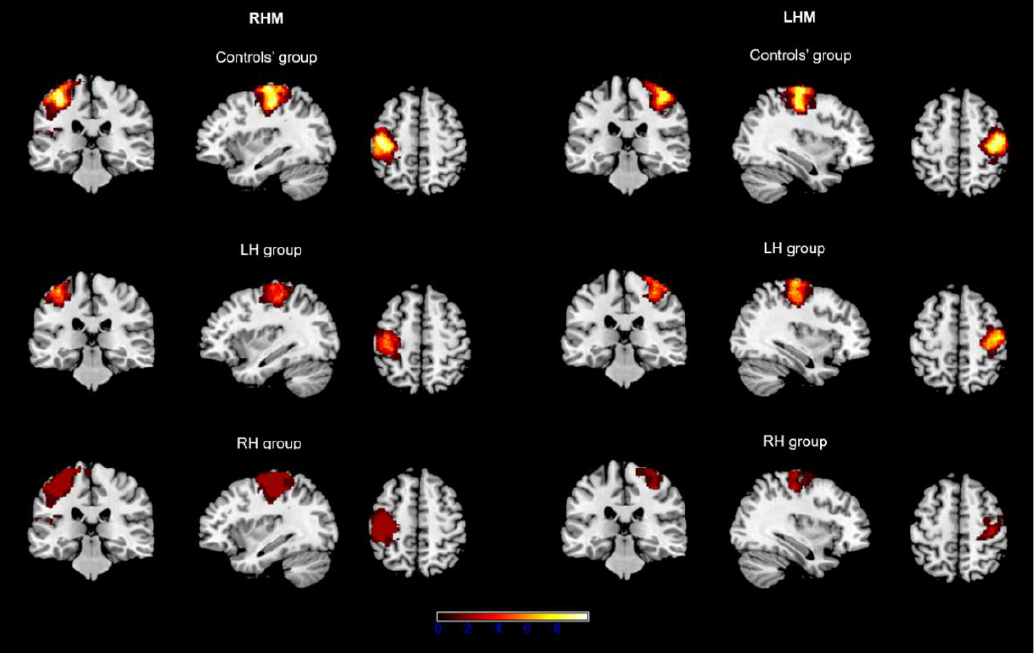
Figure 1. Rendered representation of ROI overlap in each group associated with right-hand (RHM) and left-hand (LHM) movement. Note. Images are reported in neurological convention. Color bar represents overlap intensity (i.e., number of participants for whom ROIs overlapped in a given area).